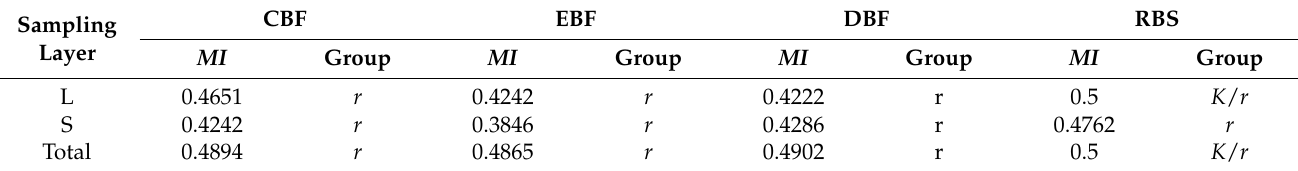
Table 7. MI values of predatory soil mites (Mesostigmata: Gamasina) in the study area.